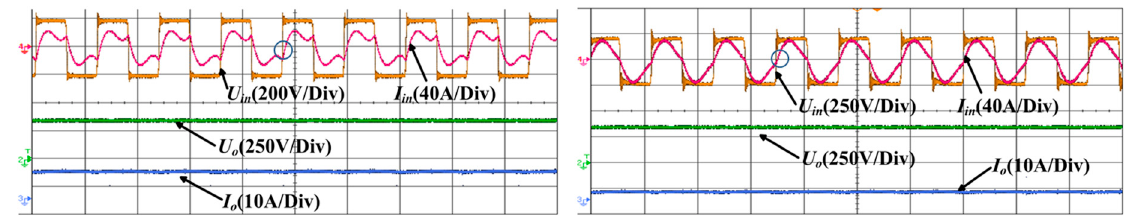
Figure 16. Under maximum R ref and minimum R ref conditions, the measured waveforms of the transmit coil current and the output current, output voltage, and θ of the inverter, with α = 1.085 and β = 0.932. ( a ) Waveforms with R ref = 1.8 Ω , θ = 11 ◦ , and I = 29.9 A; ( b ) Waveforms with R ref = 3.6 Ω , θ = 10 ◦ , and I = 29.8